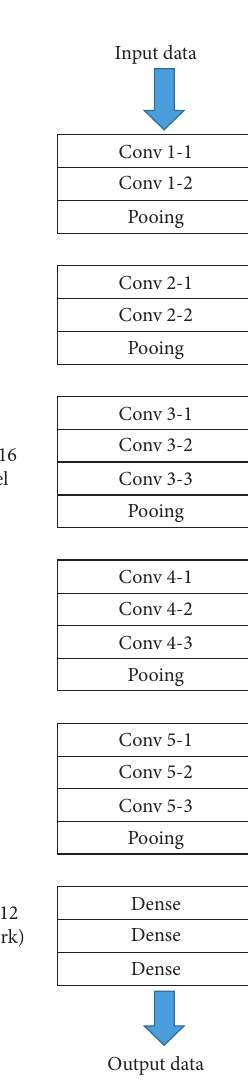
Figure 15: Flowchart of training the VGG-16 model based on [5].